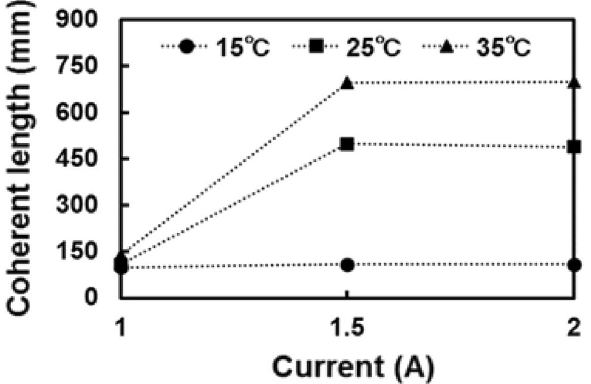
Figure 2. Coherence length relationship between current and temperature in the DFB-LD. The round, square, and triangle points represent the element temperature of 15 °C, 25 °C, and 35 °C, respectively. Coherence length can be controlled by adjusting the current and the